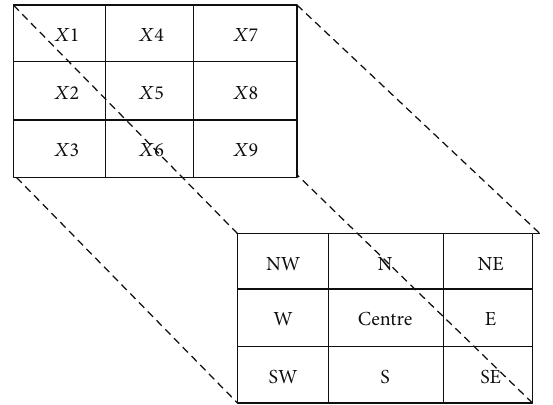
Figure 9: The figure is showing a section of an image and the neigh- borhood pixel directions with respect to the middle pixel.